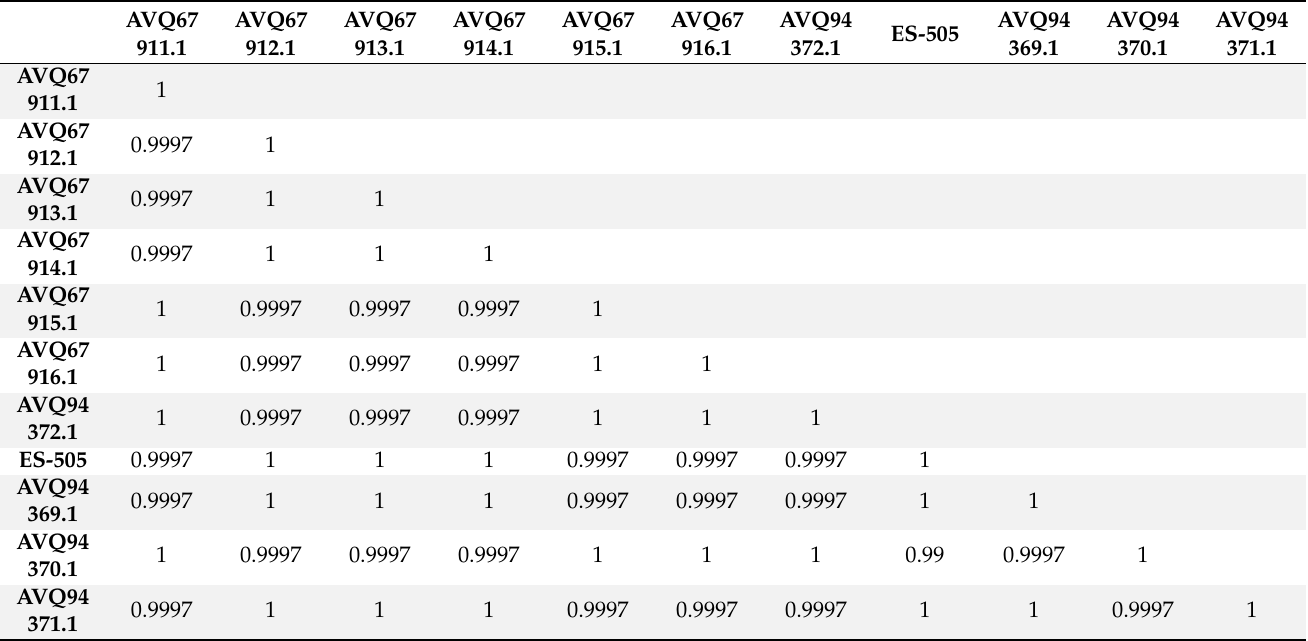
Table 1. Sequence identity matrix of isolates from the 2016–2017 Yellow Fever